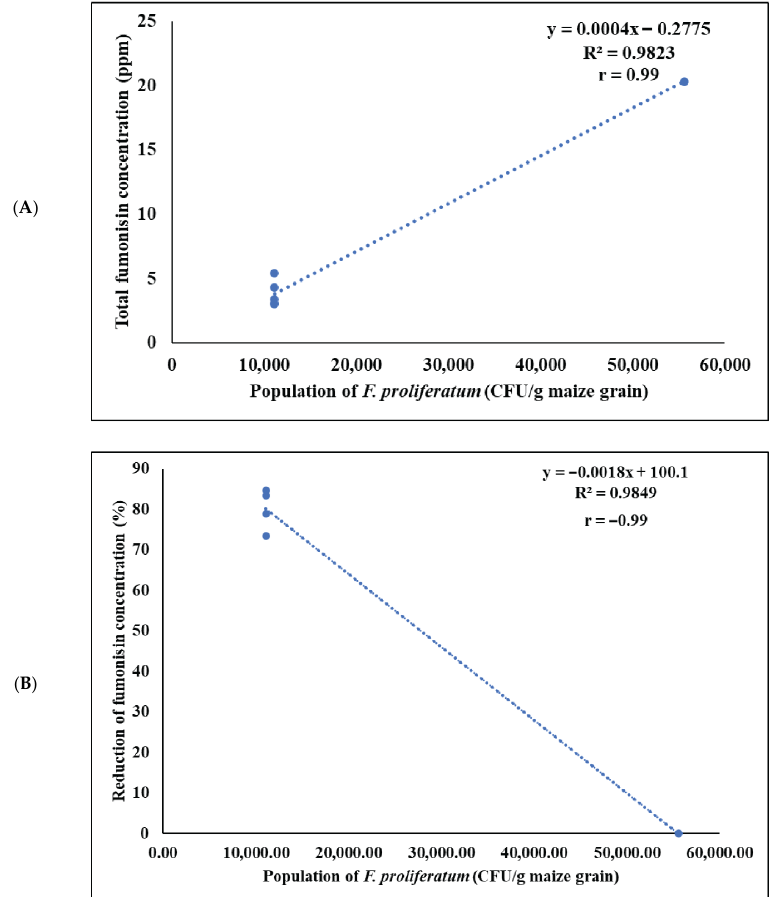
Figure 3. Linear regression showing the relationship between F. proliferatum population (CFU/g maize grain) with ( A ) total fumonisin concentration (ppm), and ( B ) reduction of fumonisin concentration (%) at 35 DAI. 3.7. Root Colonization of Different Bacillus Species in the Maize Rhizosphere Rifampicin-resistant bacteria with similar morphology of BDISO76MR ( B. subtilis MMM1), BDISO01RR ( B. amyloliquefaciens ), BDISO36PR ( B. subtilis ), BDISO45PR ( B. sub- tilis ), and BDISO49PR ( B. subtilis ), were recovered after dilution plate technique on LB media (Figure 4). Colonization was also confirmed by counting the colony-forming units per gram of root tissue (Table 4). The results revealed that the maximum colonization (82 × 10 6 CFU/g root tissue) of BDISO76MR ( B. subtilis MMM1) was recorded followed by BDISO49PR ( B. subtilis ) (51.6 × 10 6 CFU/g root tissue), BDISO45PR ( B. subtilis ) (26.3 × 10 6